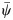
Simulation of the development of domain-specific regions.In this case the distribution of objects was biased against faces (faces were only 16 of the 156 objects in this simulation). Depth-rotation is the only transformation used here. The main assumption is that the distance along cortex between two HW-modules for two different templates is proportional to how similarly the two templates transform. See S8, S9, and S10 Figs for results of the analogous simulations using different object distributions A. Multidimensional scaling plot based on pairwise transformation compatibility ψ. B. Results on a test of view-invariant face verification (same-different matching). Each bar corresponds to a different cluster produced by an iterative clustering algorithm based on ψ¯ which models visual development—see supplementary methods. The labels on the abscissa correspond to the dominant category in the cluster. C. Basic-level categorization results: Cars versus airplanes. Error bars were obtained by repeating the experiment 5 times, presenting the objects in a different random order during development and randomly choosing different objects for the test set.